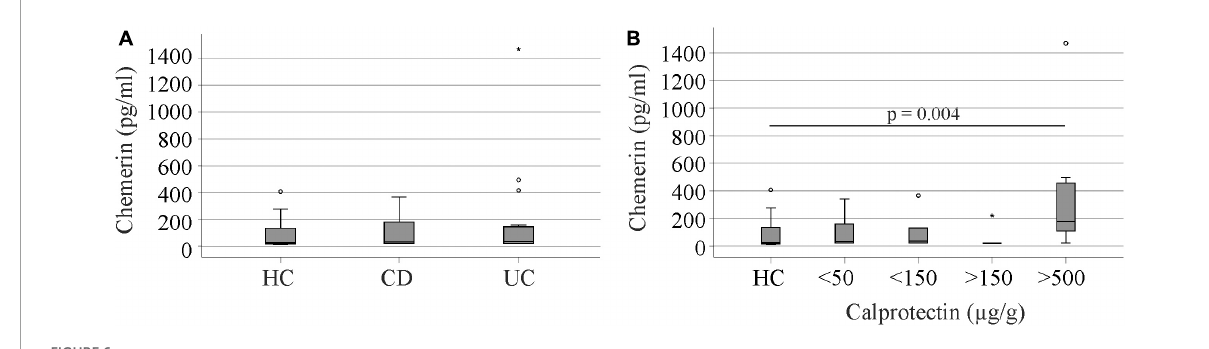
FIGURE6 Urinary chemerin protein of healthy controls (HC), Crohn’s disease (CD), and ulcerative colitis (UC) patients. (A) Urinary chemerin of HC, CD, and UC patients. (B) Urinary chemerin protein of HCs and patients stratified for fecal calprotectin levels. Circles (1.5 box lengths from the median) and asterisks (three box lengths from the median) mark